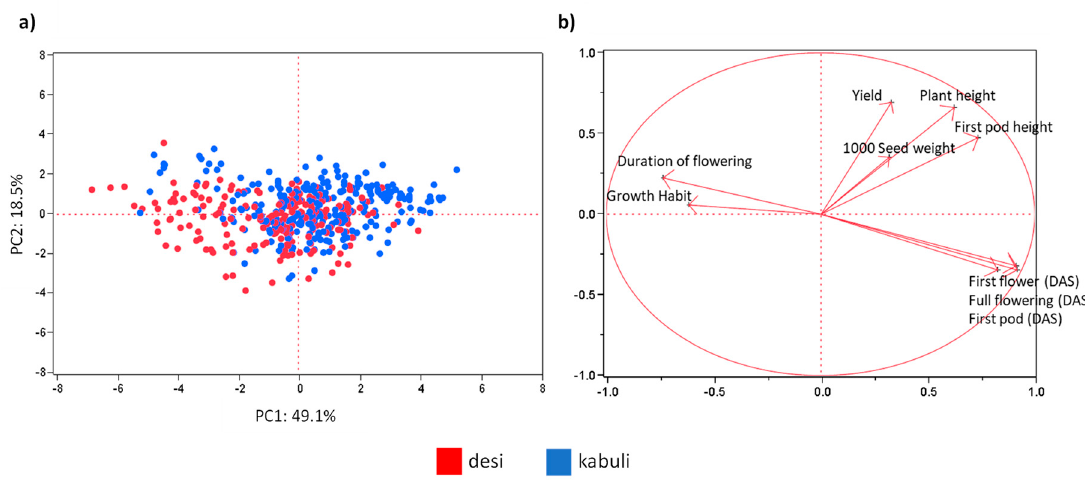
Figure 8. Principal component analysis of the UNIVPM_Ca_core2 panel based on the phenotypic traits recorded for the 2019 field trial. ( a ) Genotype distribution for PC1 and PC2, indicating the desi (red) and kabuli (blue) types. ( b ) Loading plot from the principal component analysis.